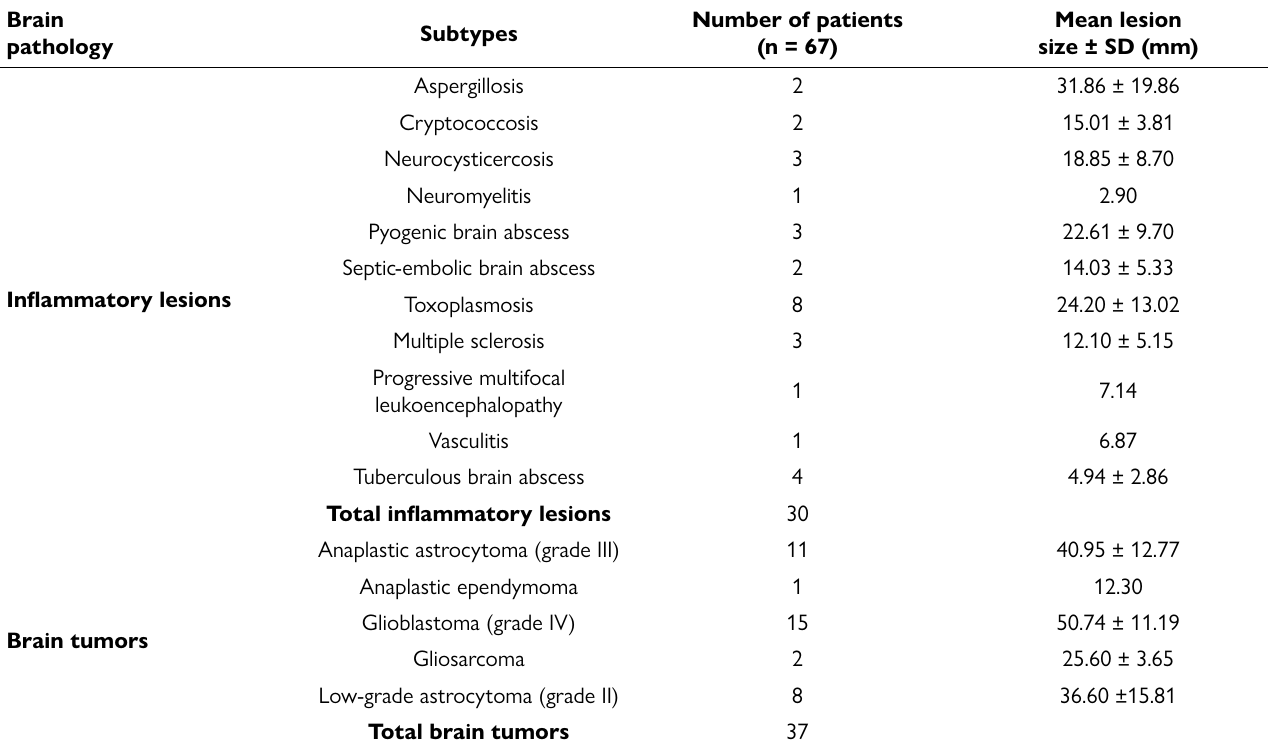
Table 1. Complete list of all pathologies that were selected for the present study, with the number of patients (n), their mean lesion size and standard deviation (SD) in millimeters.